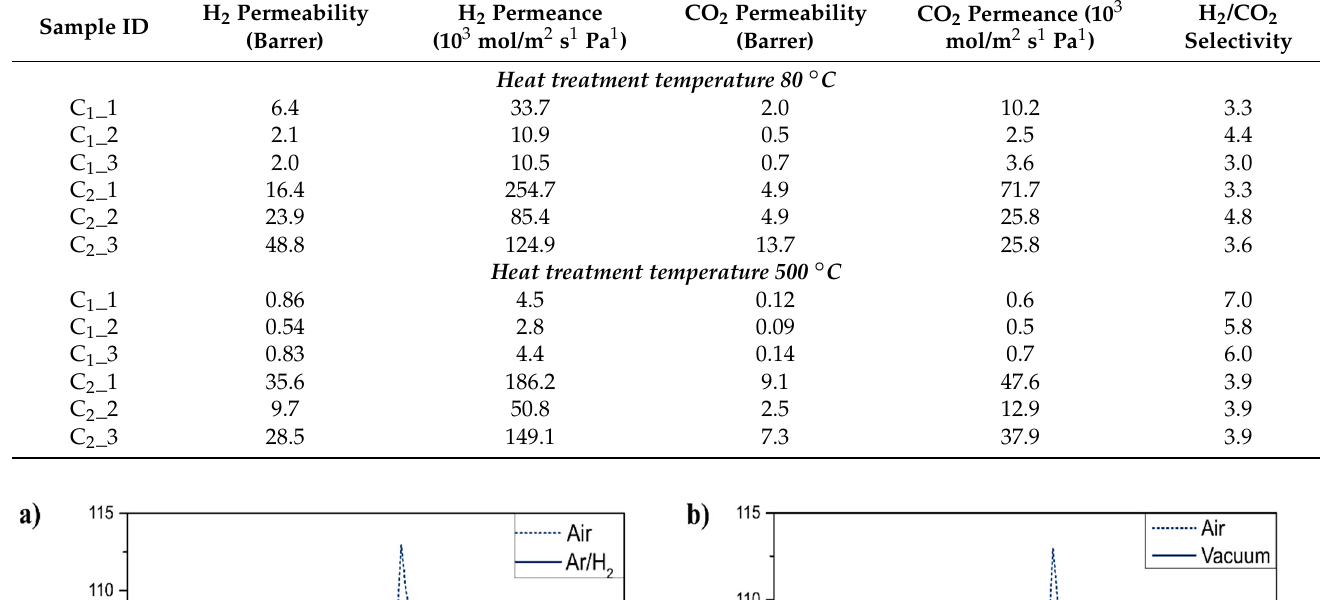
Table 2. H 2 and CO 2 permeabilities and permeances and the respective H 2 /CO 2 selectivity.